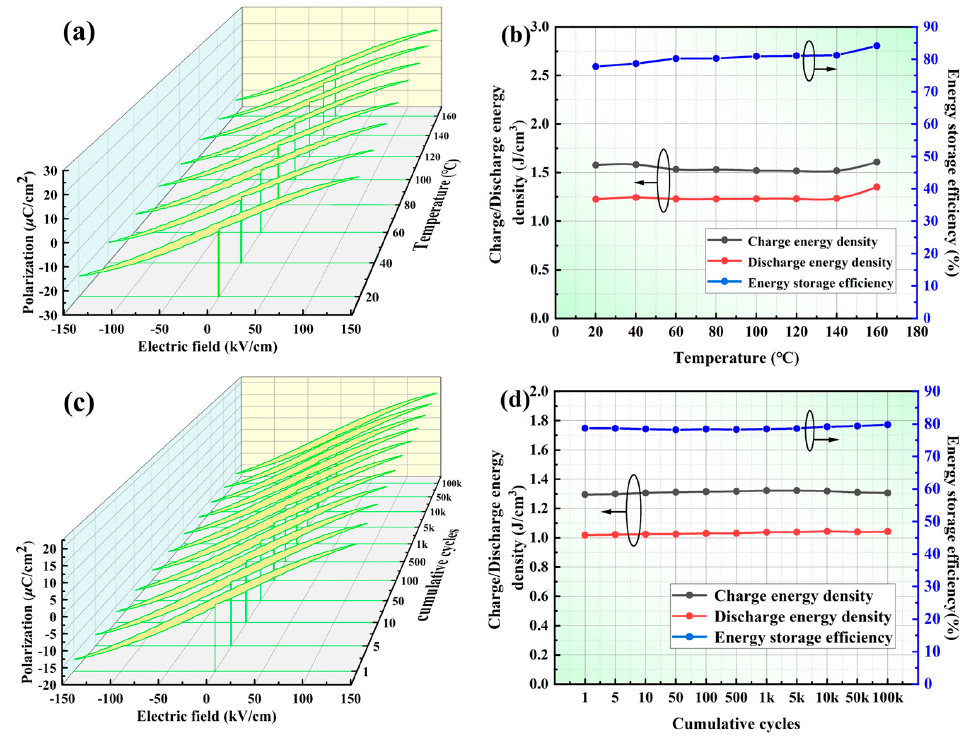
Figure 6. ( a ) Temperature-dependent P-E loops, ( b ) temperature-dependent W , W rec and efficiency of the 0.05BF-0.35BMT-0.6BT ceramics; ( c ) cyclic P-E loops; ( d ) cyclic W , W rec and efficiency of the 0.05BF-0.35BMT-0.6BT ceramics.